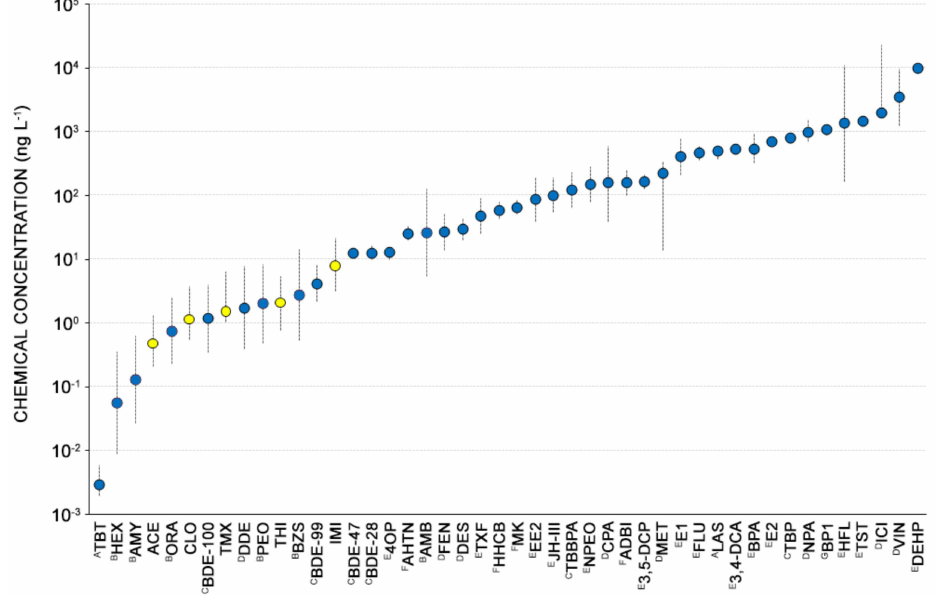
Figure 2. Toxicity of organic micropollutants toward Acartia tonsa larval development. All data refers to a 5 d exposure at 20 ± 2 ◦ C; only for TBT and LAS the exposure was prolonged up to 8 d. The 5d-EC 50 s obtained in the present work are highlighted with yellow dots. TBT = tributyltin; HEX = hexil salicylate; AMY = amyl salicylate; ACE = acetamiprid; ORA = oranger crystals; CLO =